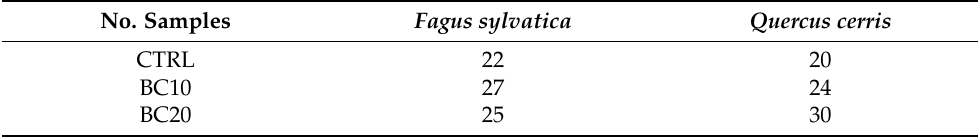
Table 4. Total seedling number (statistical replicates) for Fagus sylvatica and Quercus cerris for each treatment: CTRL (control), BC10 (10% BC), and BC20 (20% BC). No. Samples Fagus